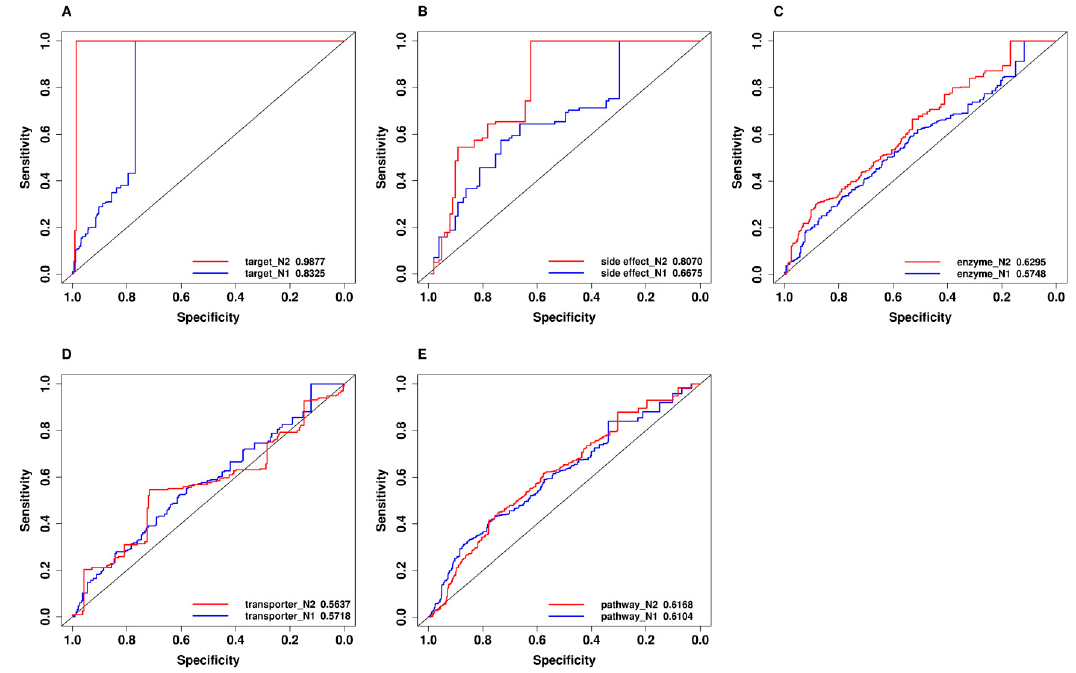
Figure 2. The performance comparison of models on two different negative data sets by using leave-one-out cross validation on five types of single features. The performance of the N1 negative data set is shown by the blue line, whereas the performance of the N2 negative data set is shown by the red line: ( A ) The enzyme feature; ( B ) The pathway feature; ( C ) The side effect feature; ( D ) The transporter feature; ( E ) The target feature.